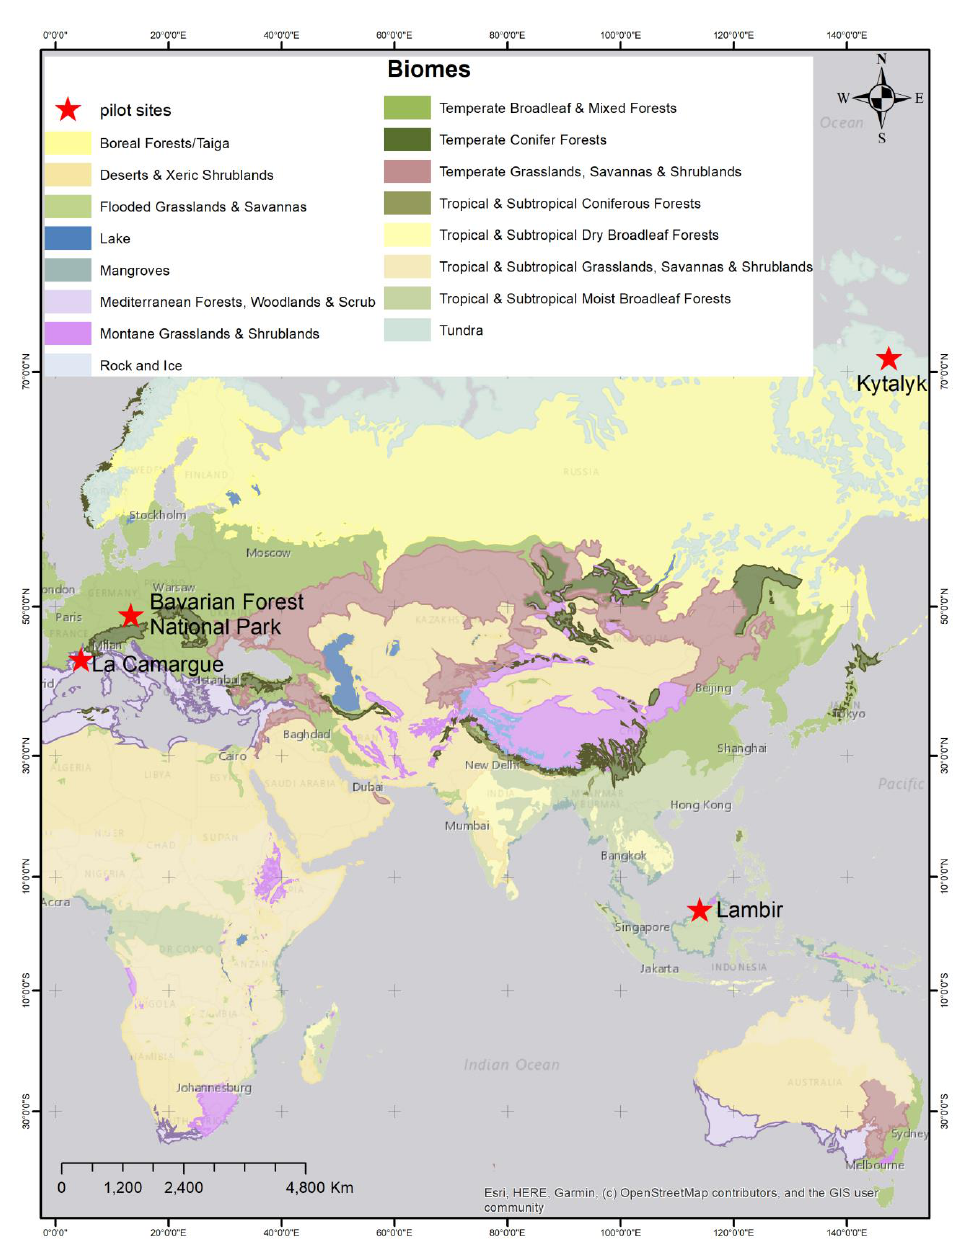
Figure 1. The four selected pilot sites from terrestrial biomes.